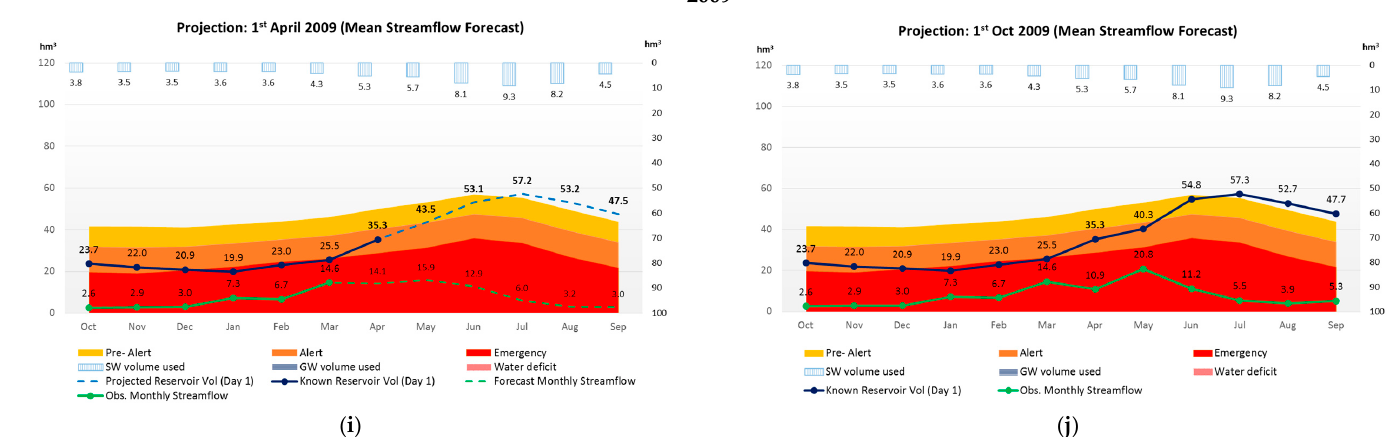
Figure 7. Using streamflow forecast models (in this case, AQUAFOR): Measures taken in April ( a,c,e,g,i ) and evaluation of the real situation made in October ( b,d,f,h,j ).